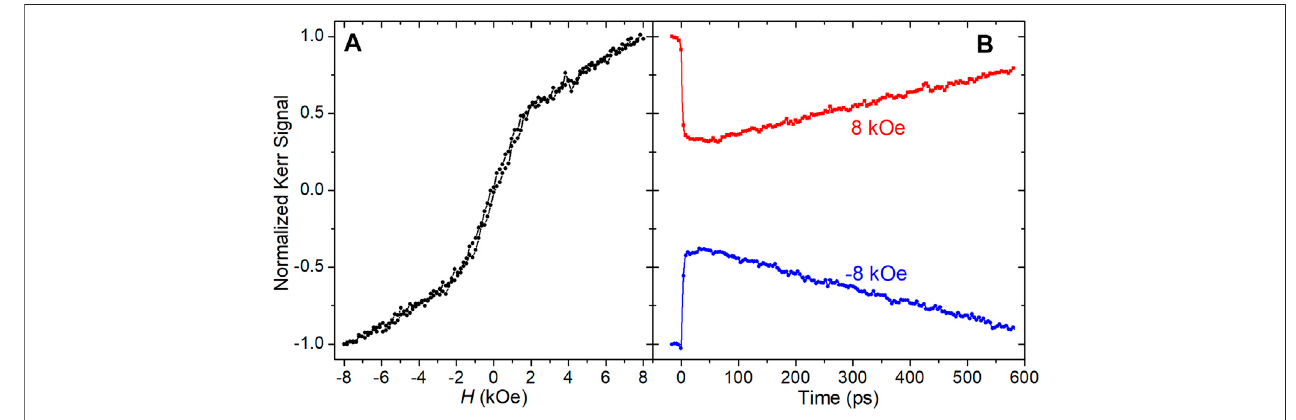
FIGURE 1 | (A) Normalized polar Kerr hysteresis loop of the GdFeCo layer. (B) Laser-induced magnetization dynamics measured under H (cid:1) ± 8 kOe and pump fl uence of 9.8 mJ/cm 2 . The Kerr signal is normalized to the static Kerr value at H (cid:1) ± 8